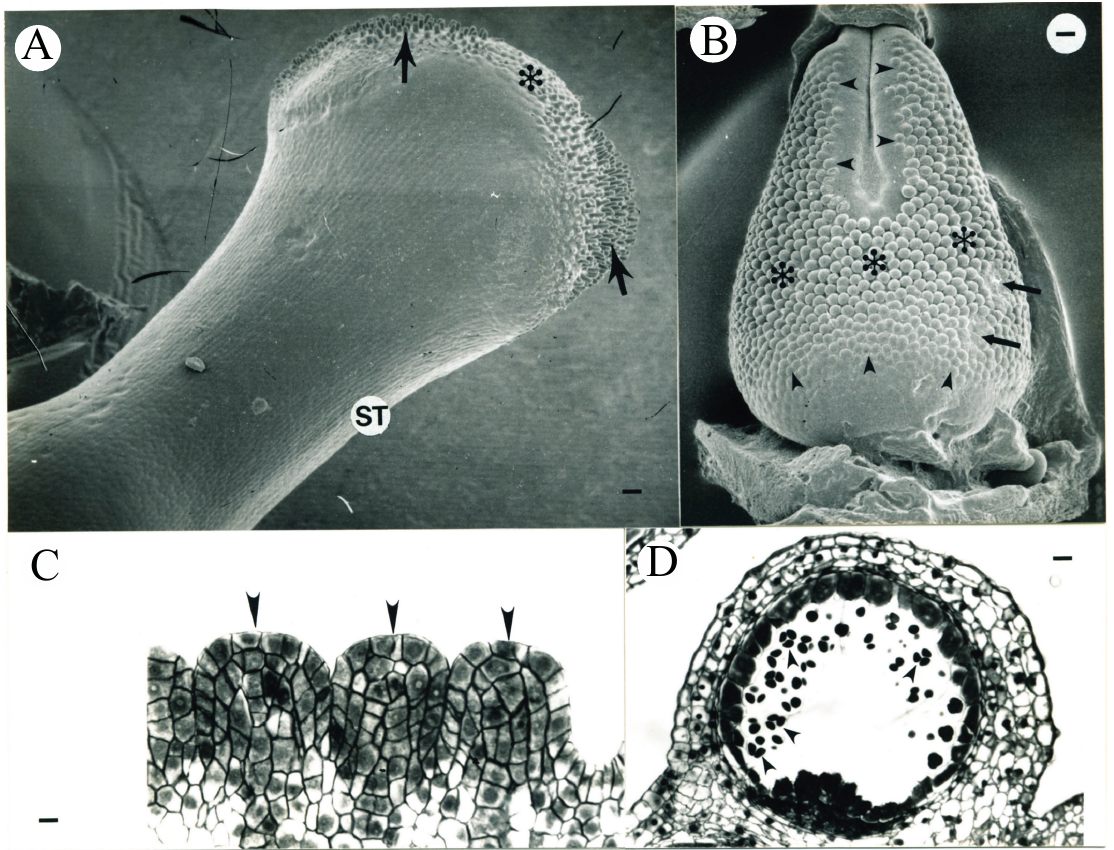
Figure 7. Tobacco pistil and anther development within 10.9 ± 1.1 days after ECP. ( A ) SEM micrograph of the stigma (asterisk) and the elongating style (ST). The papillar cells in the stigma di ff erentiate on two distal areas (arrows) of the two carpels. Bar = 34.1 µ m. ( B ) The placenta of the same pistil seen in ( A ) showing the enlarging ovule primordia. Larger ovules are in the middle portion of the placenta (asterisks), while smaller ovules and initiating ovule primordia are in the peripheral regions (arrowheads) of the placenta. Damage to the ovules (arrows) occurred when the pistil was removed from the mould. Bar = 65.2 µ m. ( C ) Median longitudinal sections of three ovule primordia (arrowheads) from the placenta seen in ( B ). Bar = 8.2 µ m. ( D ) Transverse section of an adaxial microsporangium showing the tetrads of microspores (arrowheads). Bar = 24 µ m.